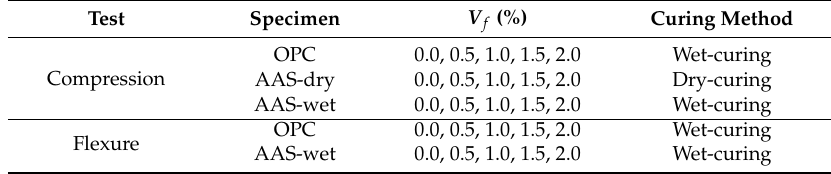
Table 3. Variables for mechanical